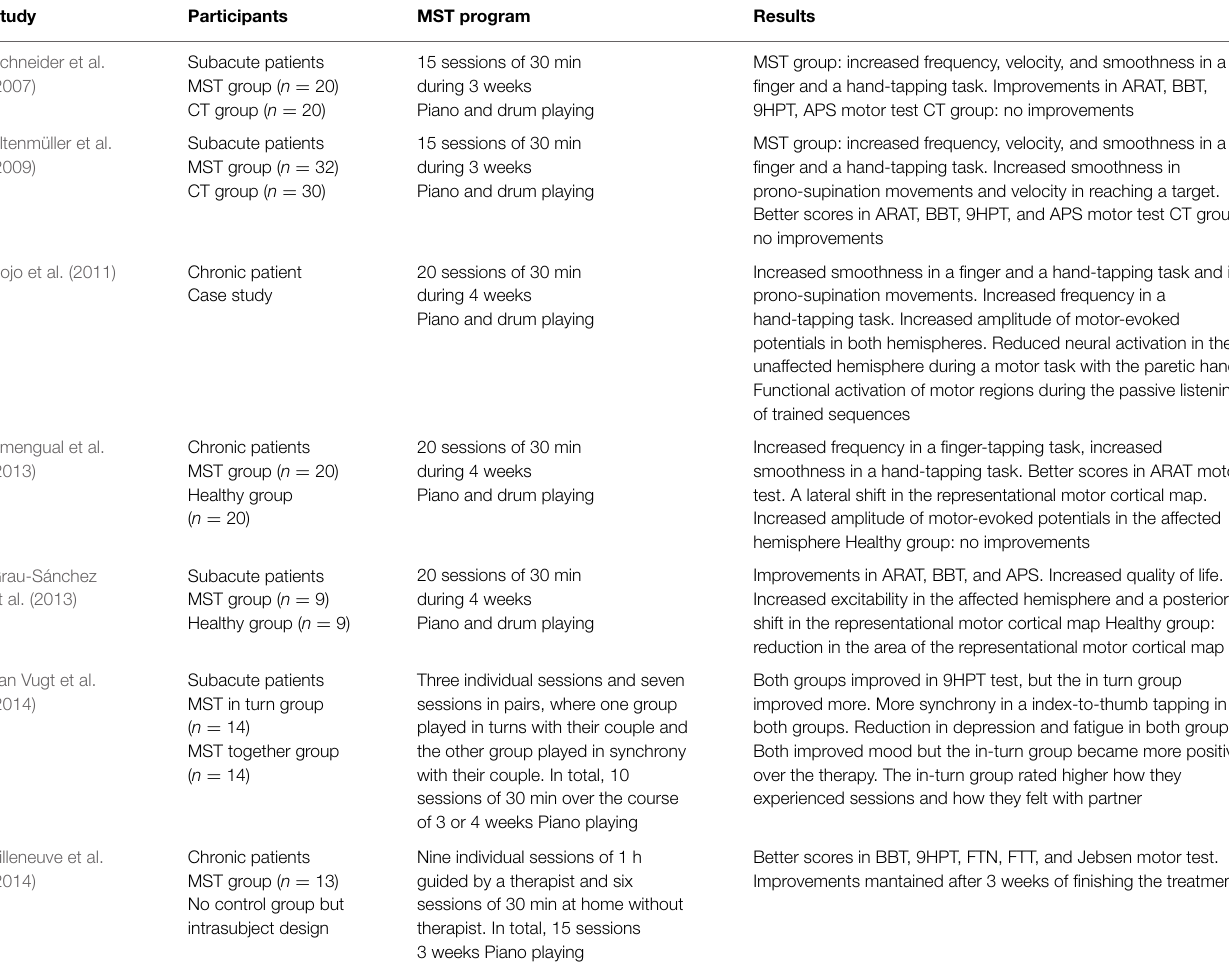
TABLE 1 | Summary of the studies evaluating MST to restore upper limb paresis in stroke